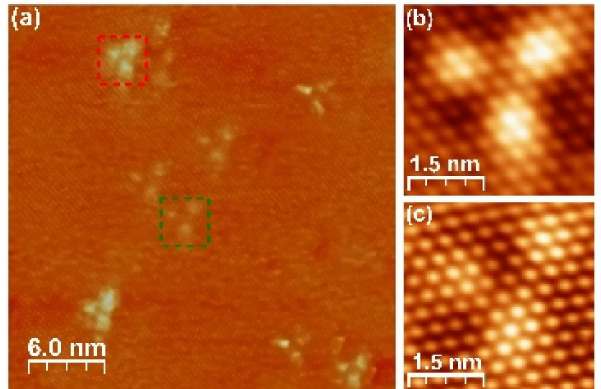
Figure 2. STM topography scans recorded at room temperature, V bias = − 340 mV, I = 300 pA. ( a ) 30 × 30 nm STM image of the Bi 2 Se 3 surface, revealing the most frequent types of defects in the 5th and 6th atomic layer marked with the red and green square, respectively. ( b , c ) high resolution STM topography scans depicting surface images of the defect in the 5th atomic layer ( b ) and in the 6th atomic layer ( c ) in Bi 2 Se 3 .